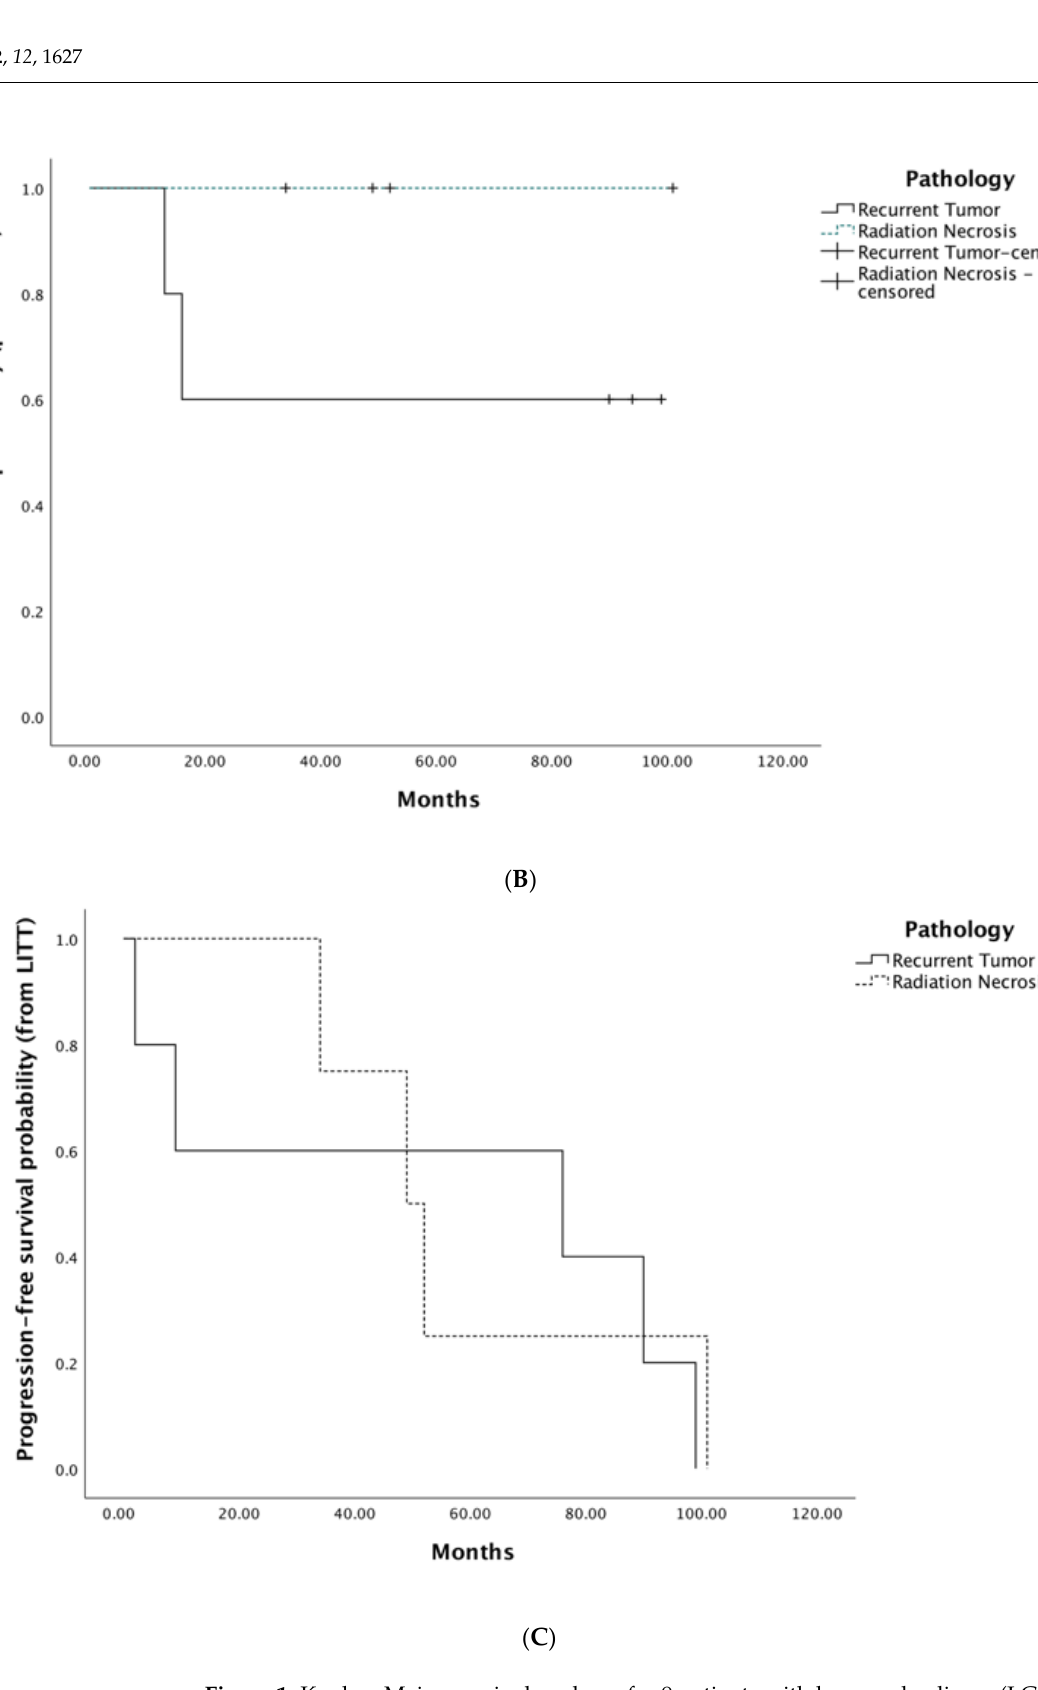
Figure 1. Kaplan–Meier survival analyses for 9 patients with low-grade glioma (LGG) or radiation necrosis (RN) treated with laser interstitial thermal therapy (LITT). ( A ) Cumulative overall survival from time of diagnosis. ( B ) Cumulative survival after treatment with LITT. ( C ) Progression-free sur- vival after treatment with LITT.